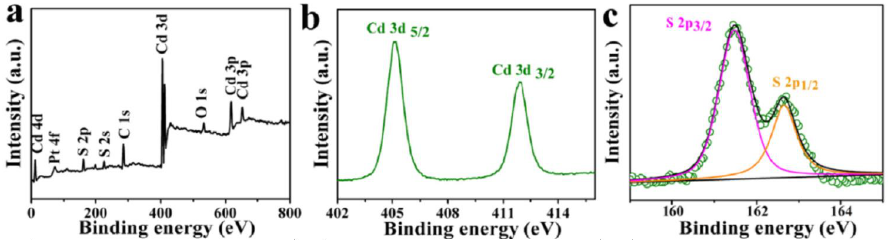
Figure 24. ( a ) XPS of Pt-CdS and the corresponding high-resolution XPS spectra of Pt–CdS, ( b ) Cd 3d, and ( c ) S 2p. Reproduced with permission from